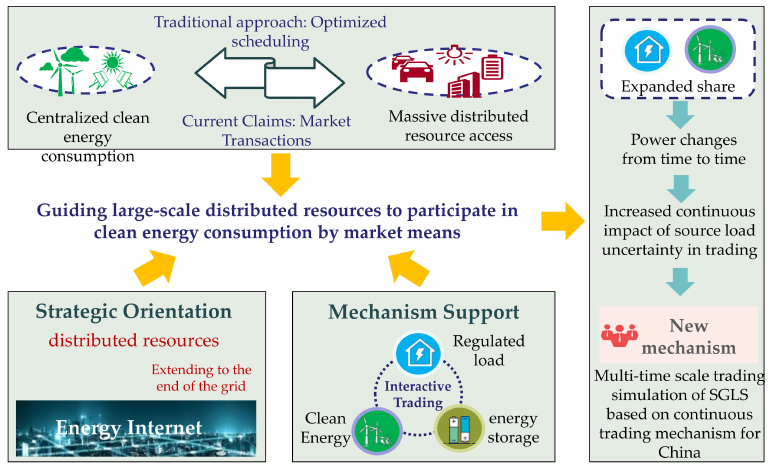
Figure 1. Background on the application of the continuous trading mechanism and simulation method for